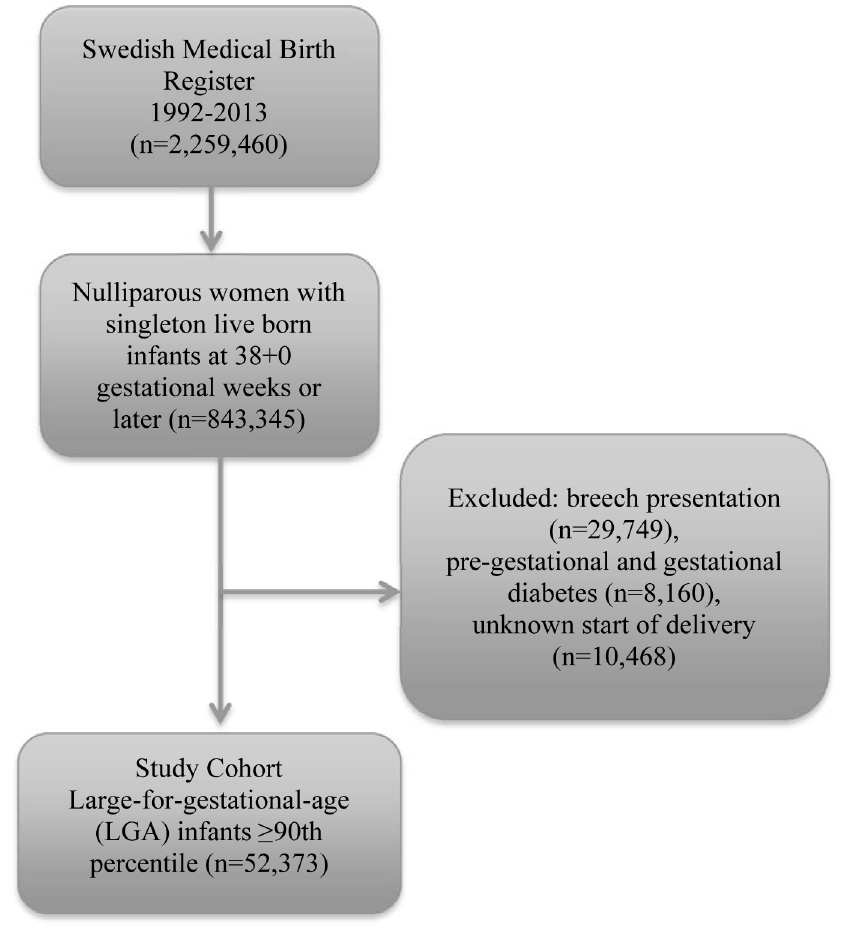
Fig 1. Study cohort flow